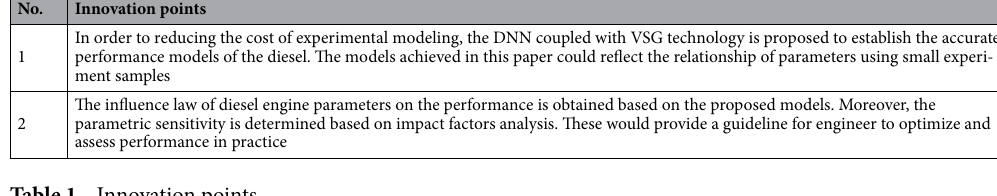
Table 1. Innovation